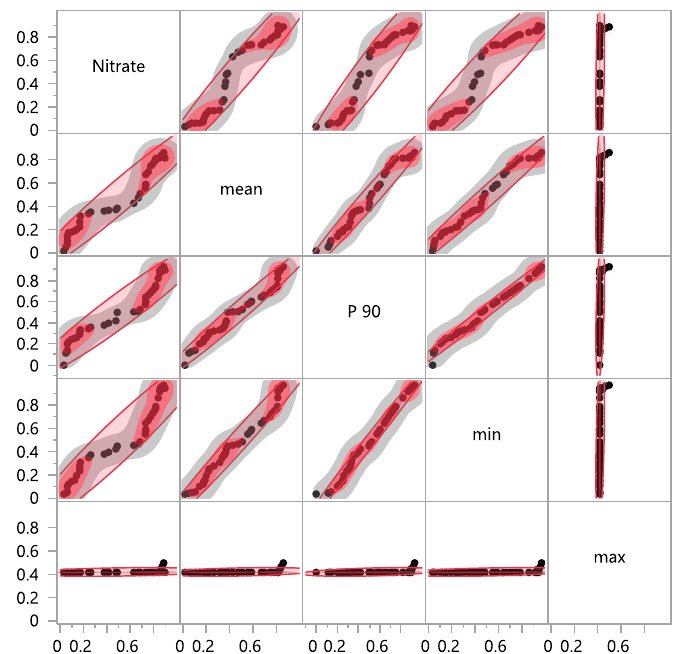
Figure 6. Scatter plot matrix of GNDVI—actual and different zonal estimated values.